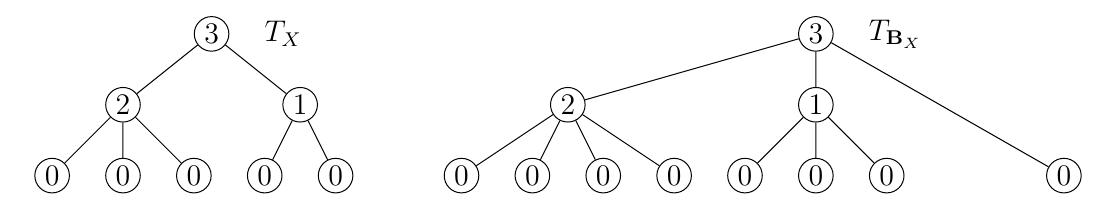
Figure 5: The representing tree T the representing tree T